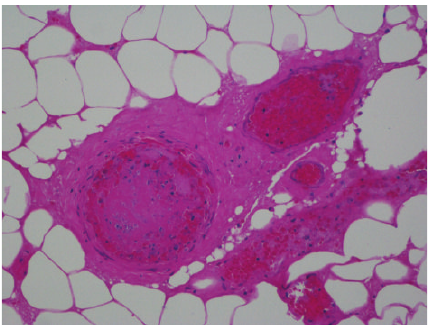
Figure 5: Fibrin thrombus